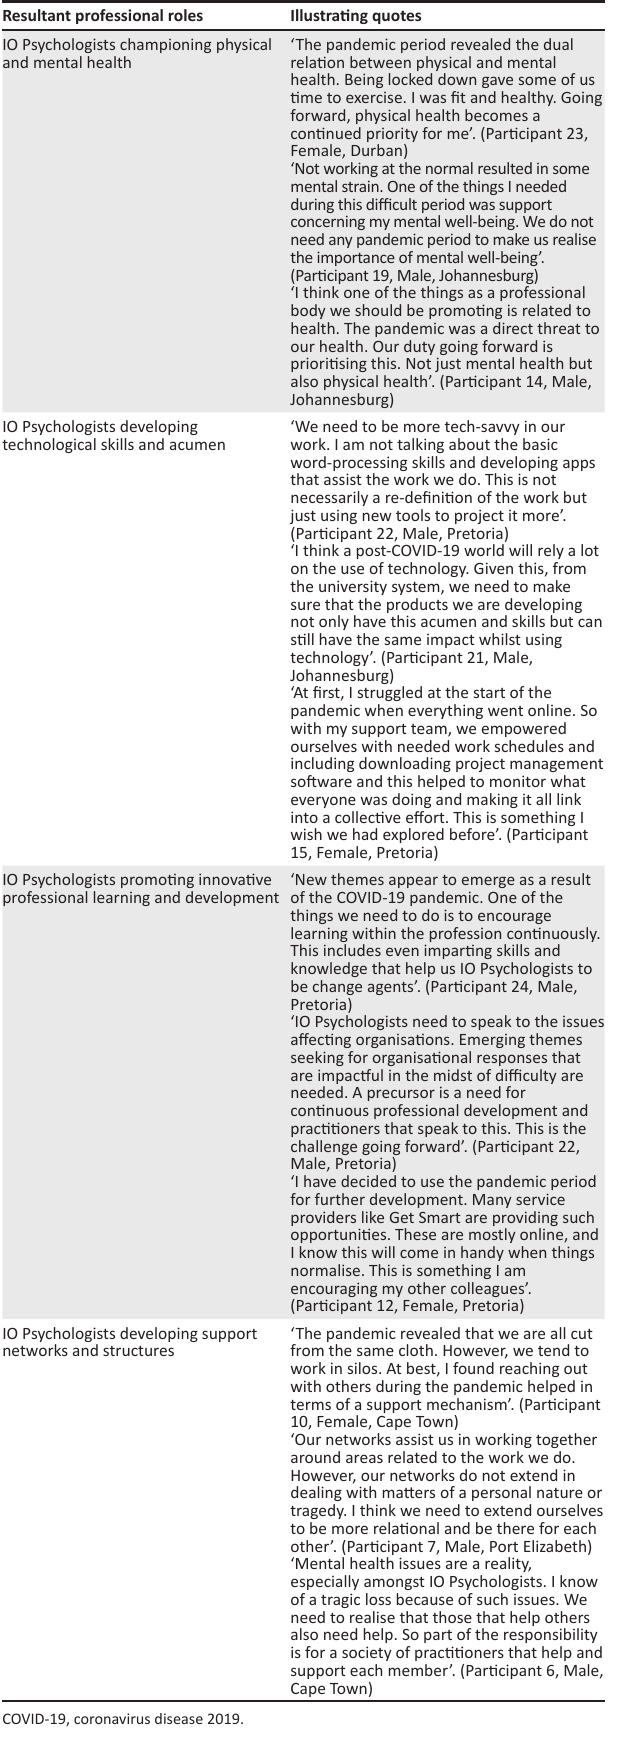
TABLE 4: Resultant professional roles: Illustrating quotes. Resultant professional roles Illustrating